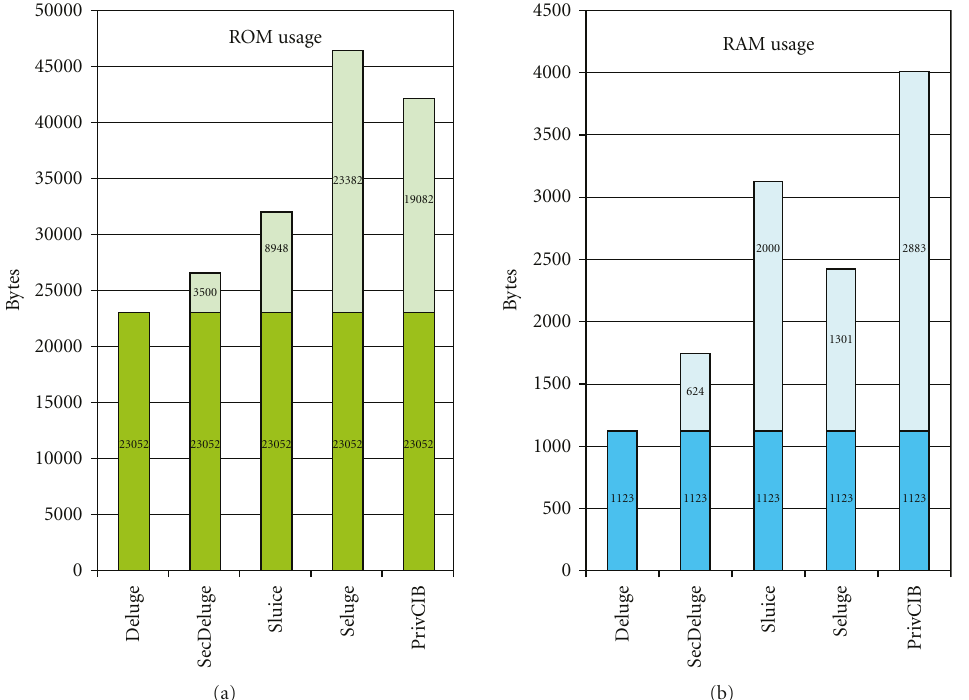
Figure 3: ROM and RAM usage of Deluge, SecDeluge, Sluice, Seluge, and PrivCIB.